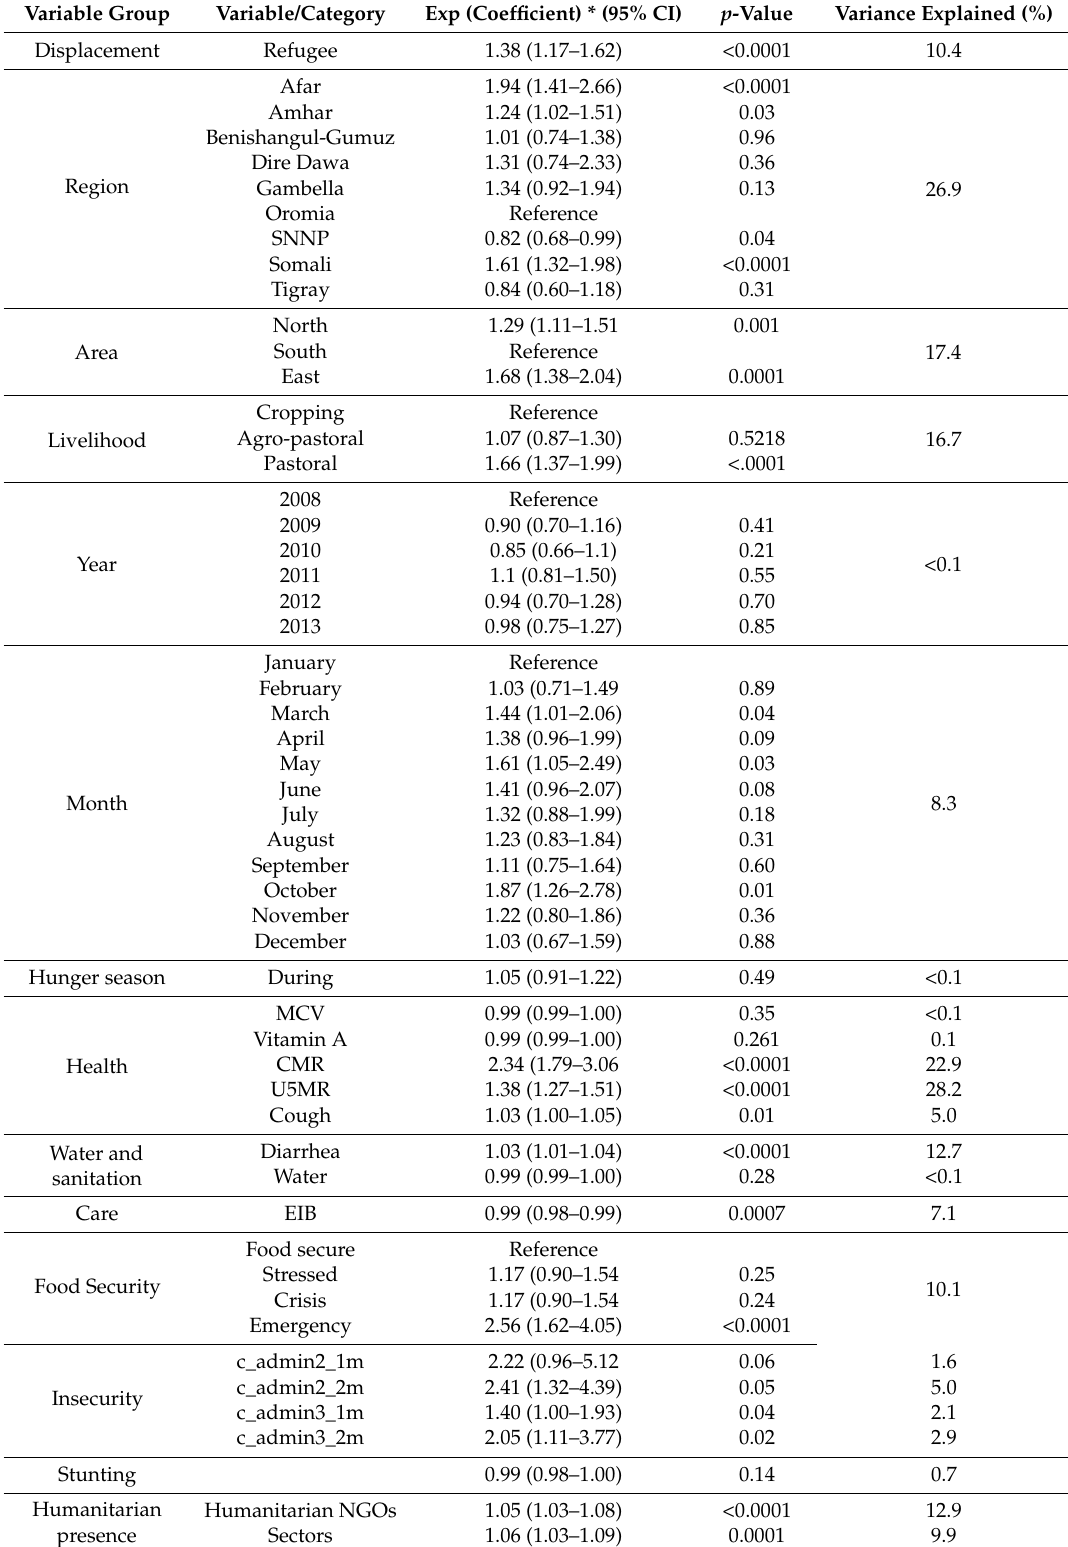
Table 3. Results of meta-regression of nutrition surveys, Ethiopia emergency pockets, 2008–2013, bivariate